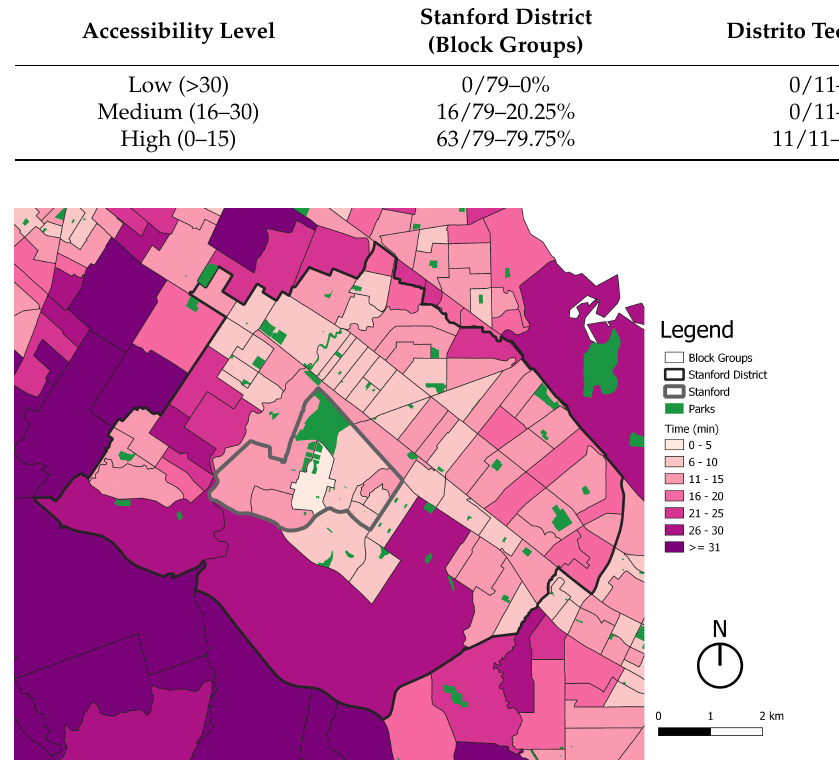
Figure 18. Stanford District average travel time to the closest park by